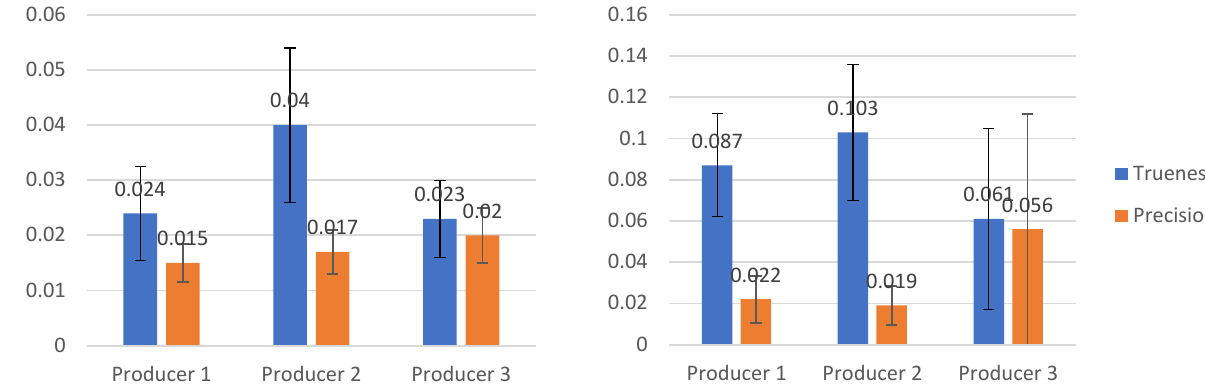
Figure 10. Buccolingual ( left ) and mesiodistal ( right ) measurements for the three material types.